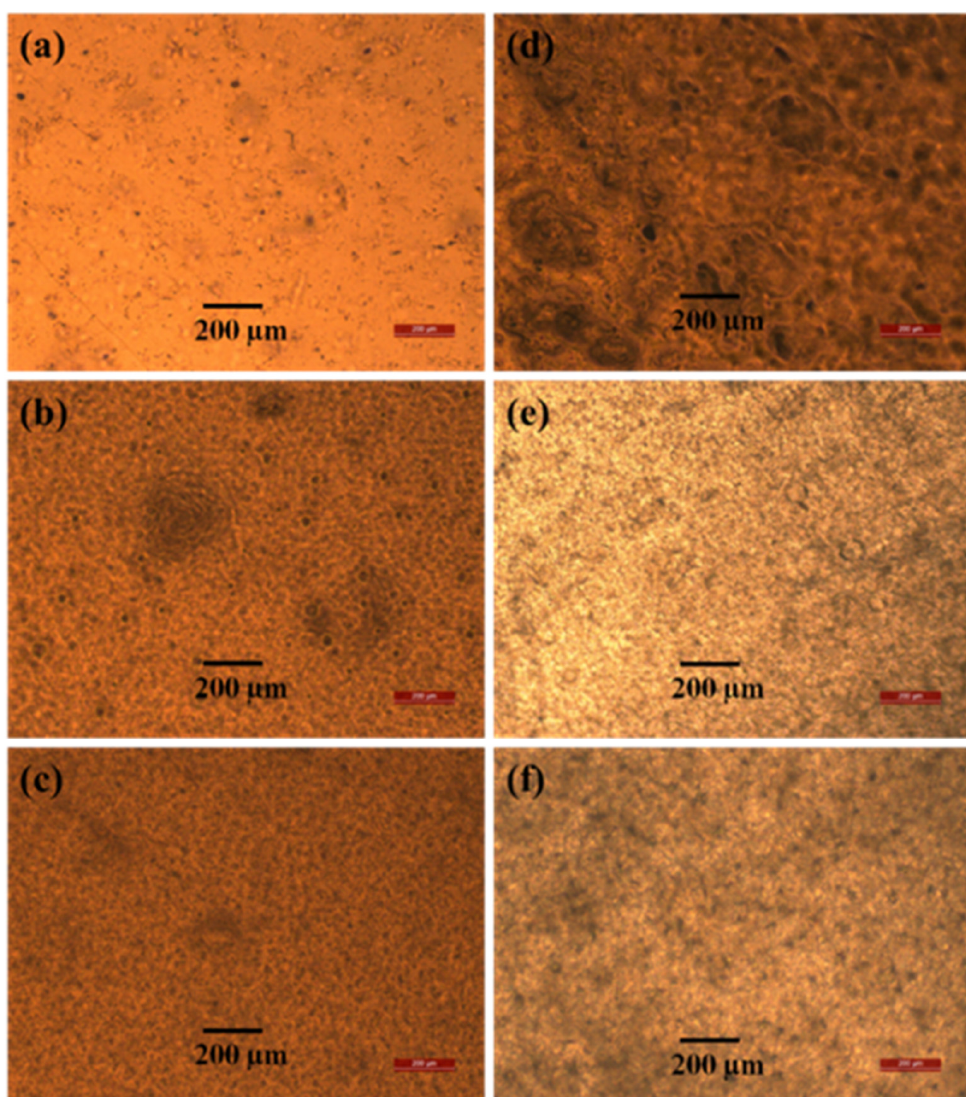
Figure 2. Optical microscopy images of unsaponified ( a ) PVAc film, ( b ) PVAc/PVB 90/10 film, and ( c ) PVAc/PVB 80/20 film and saponified ( d ) PVAc film, ( e ) PVAc/PVB 90/10 film, and ( f ) PVAc/PVB 80/20